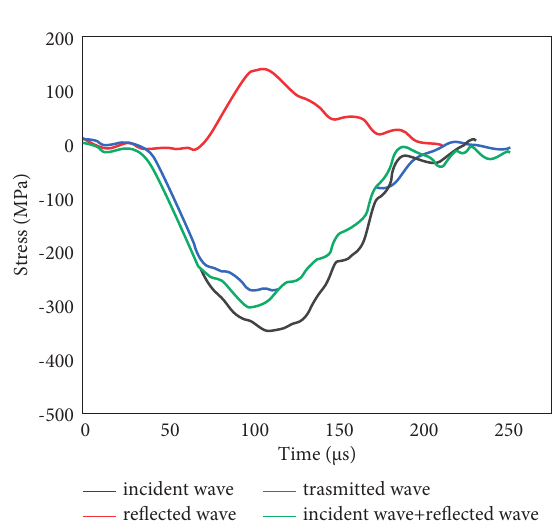
Figure 2: Stress wave equilibrium.